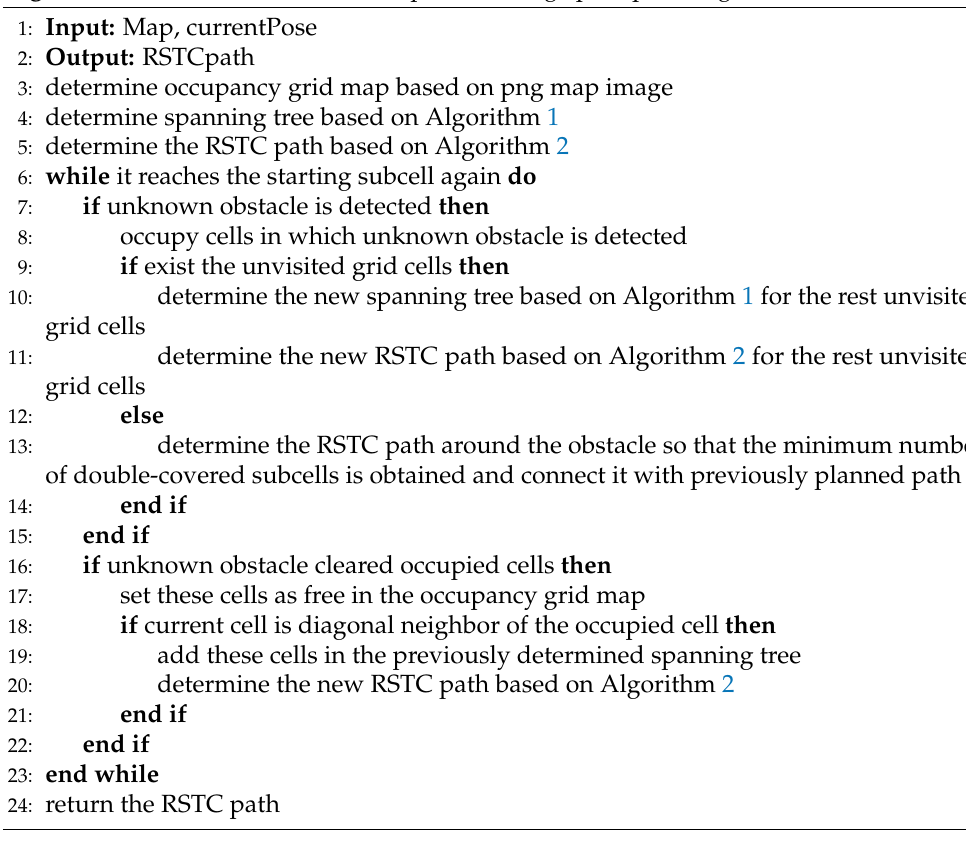
Algorithm 3 Pseudocode for the complete coverage path